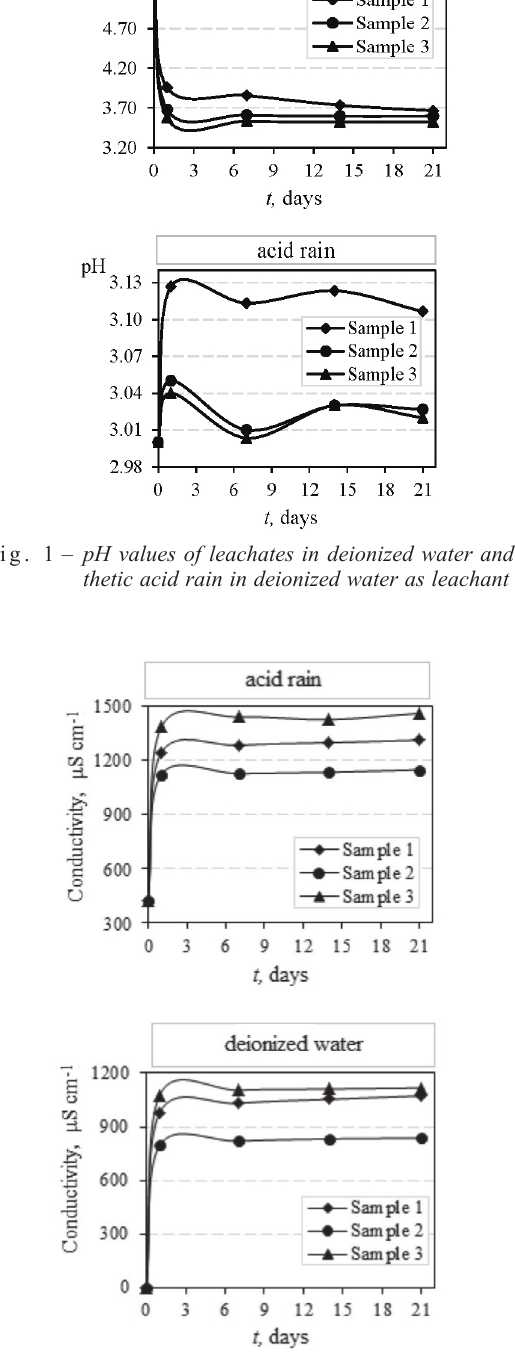
Table 1 – Total metal content in jarosite waste samples (n = 3) Element